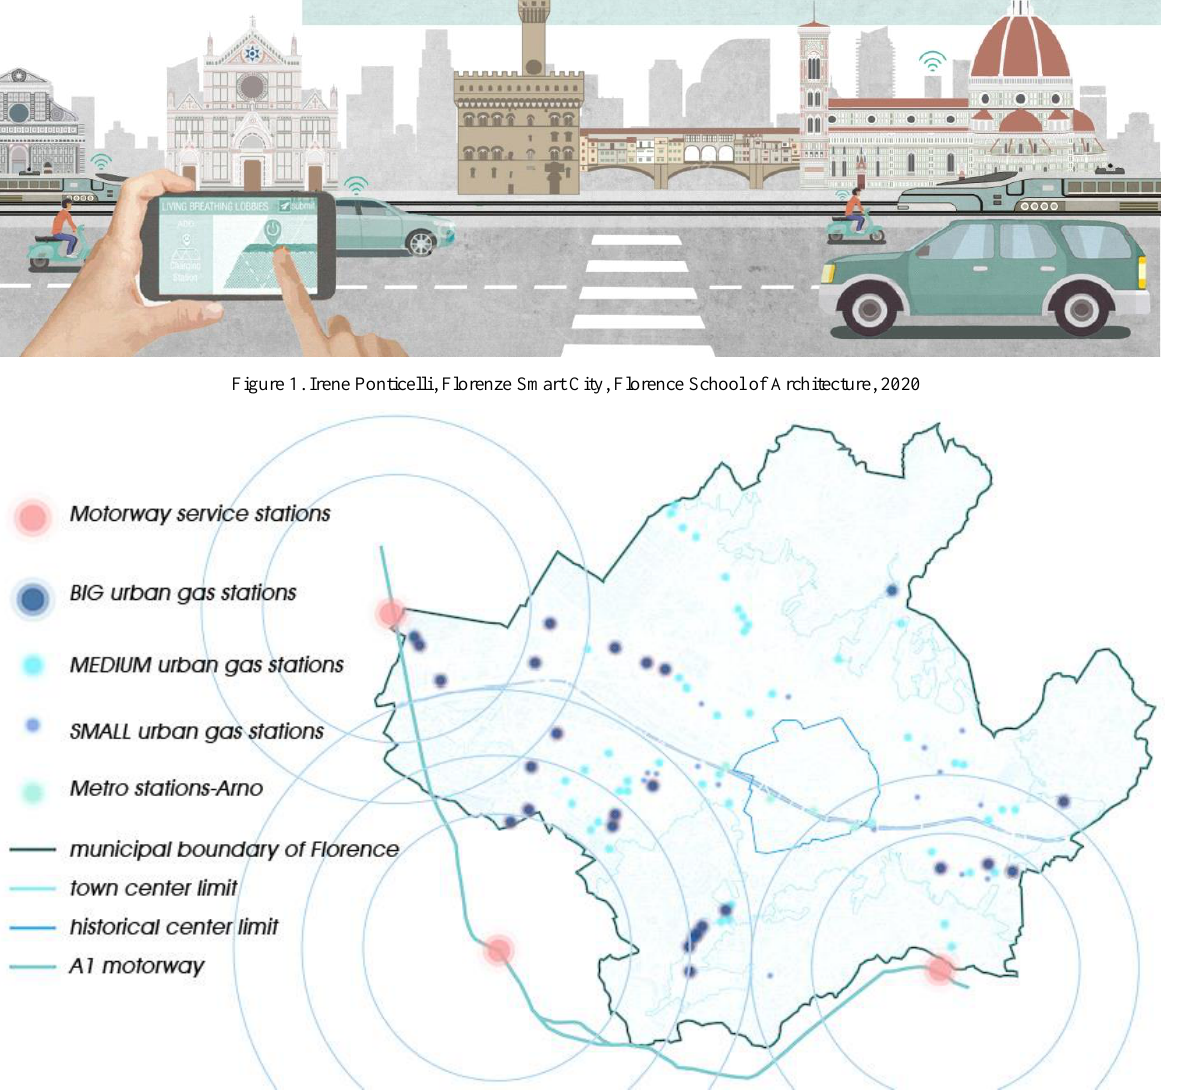
Figure 2. Existing and newly planned fuel service stations in the municipality of Florence, Florence School of Architecture,